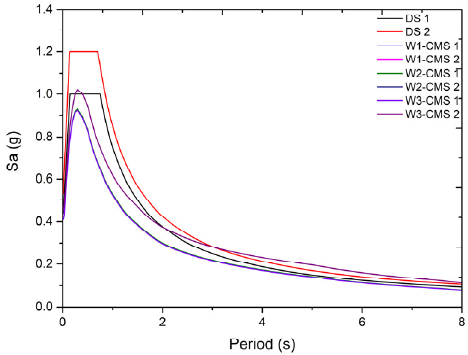
Figure 2. Target spectra for the IGM selection and scaling.